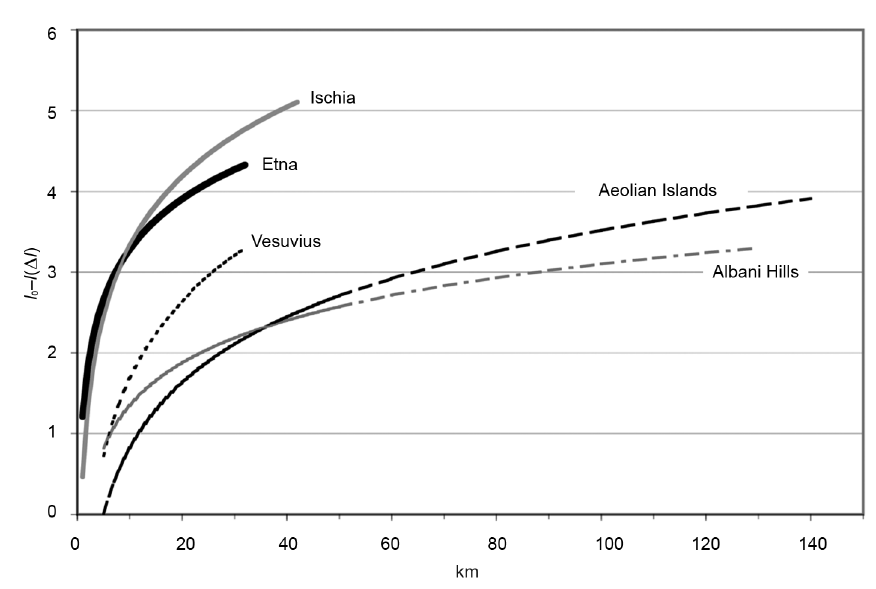
Fig. 13. Comparison of the intensity attenuation relationships obtained for the Italian volcanic